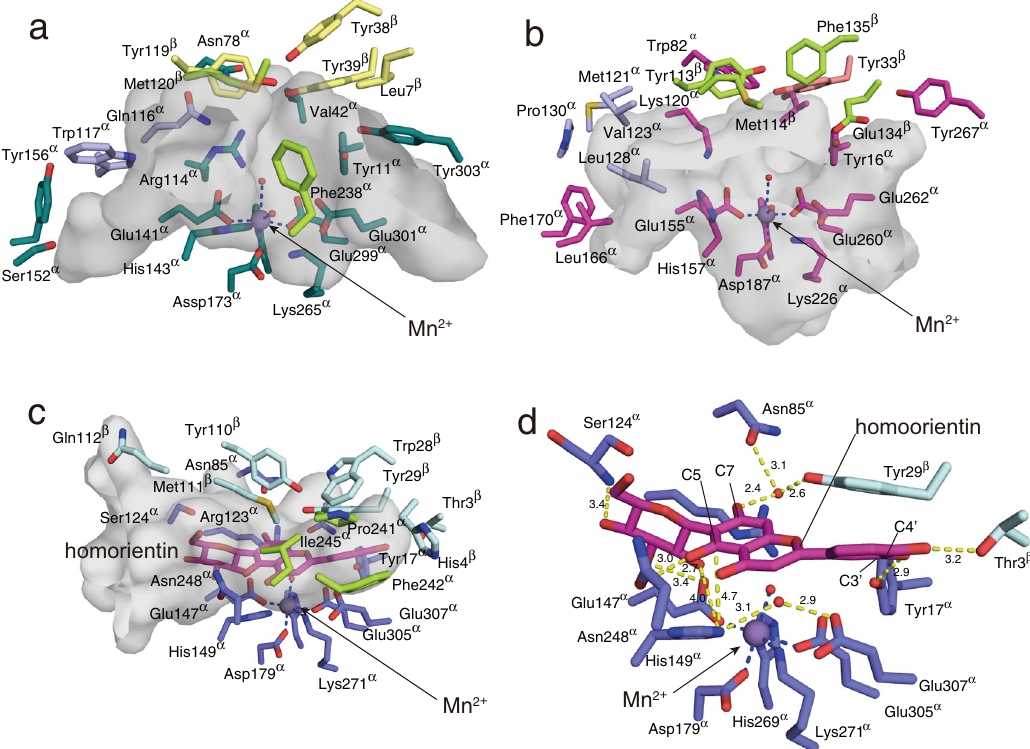
Fig. 5 Comparison of the active site architectures of C -deglycosylation enzymes. a – c Comparison of the active sites of ( a ) Pu CGD, ( b ) Eu CGD, and ( c ) Ag CGD2 with homoorientin (colored in magenta). Side views of the active site cavities are depicted as gray surfaces. d Interactions between homoorientin and active site residues in Ag CGD2. The hydrogen bonds are shown by dashed yellow